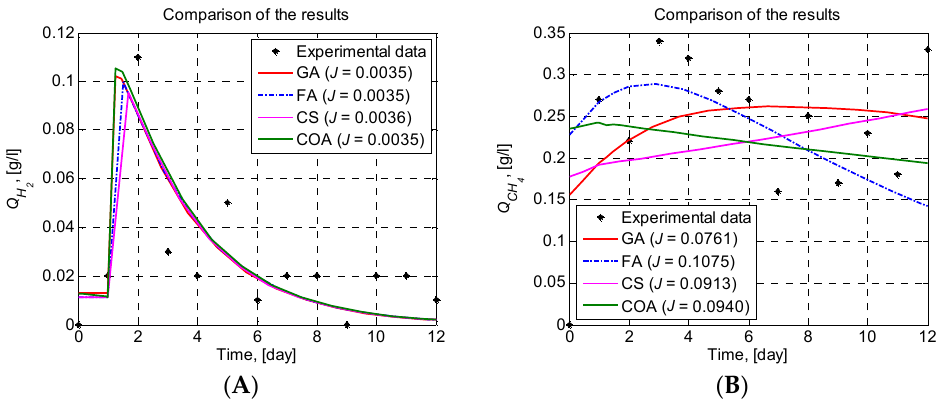
Figure 2. Graphical comparison of the results. ( A ) 𝑄 (cid:3009)